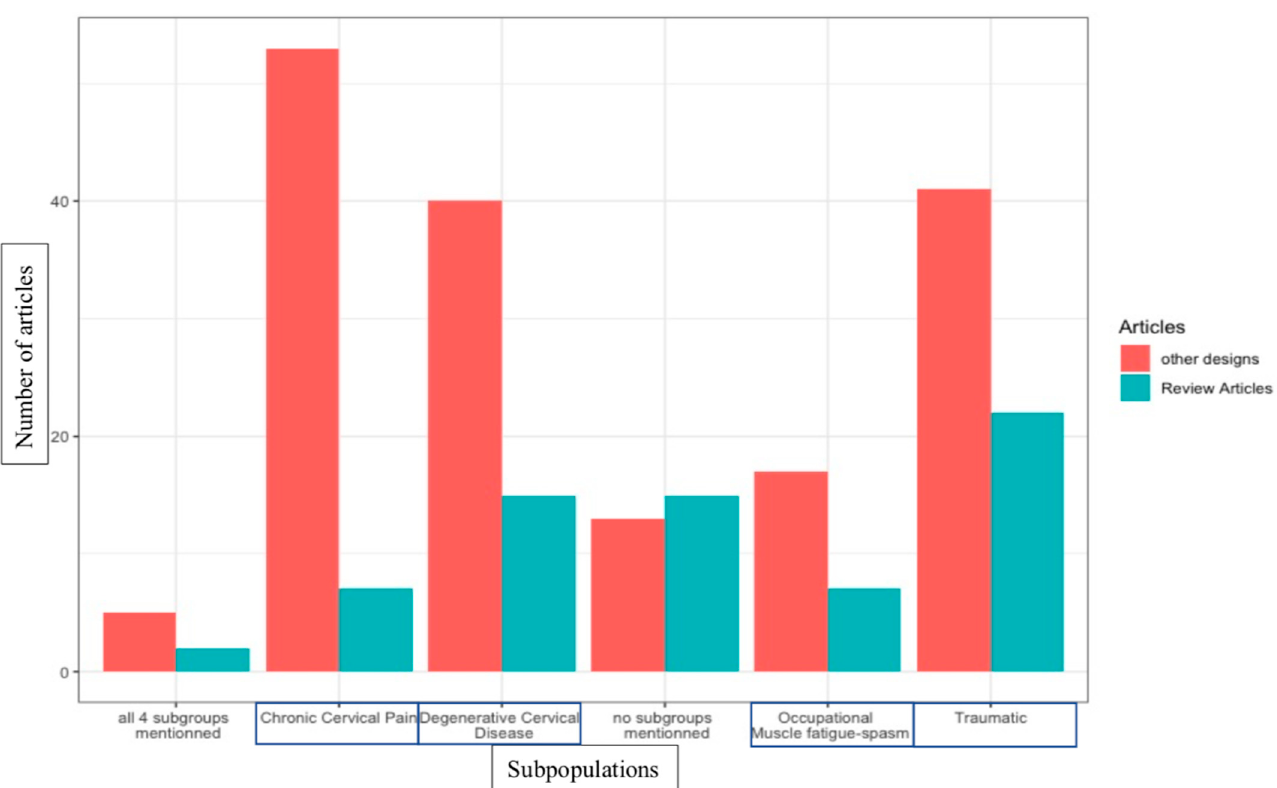
Table 1. Subpopulations, clinical presentation and hypothesized etiological